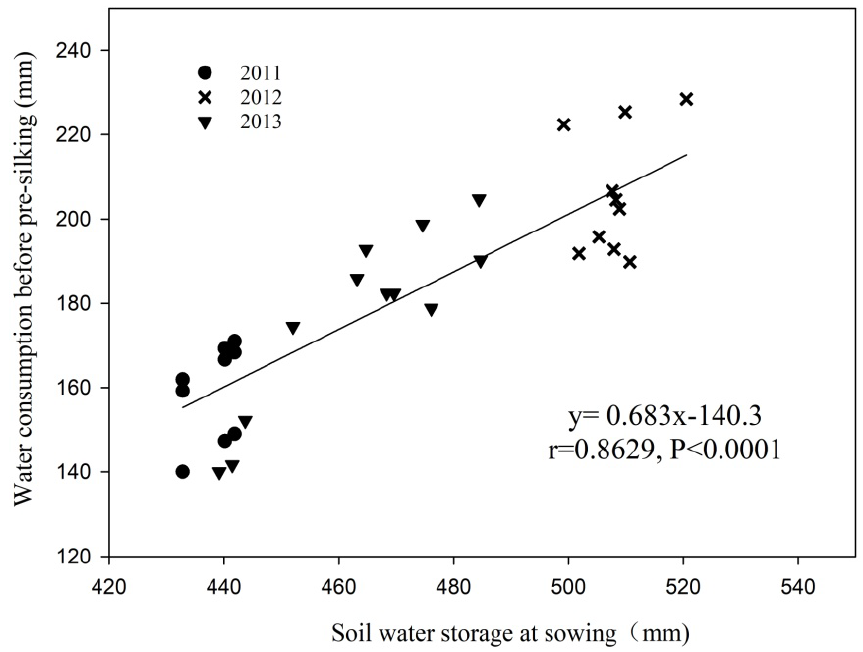
Figure 6. Correlations between the soil water storage at sowing and the average pre − silking water consumption for 3 years.